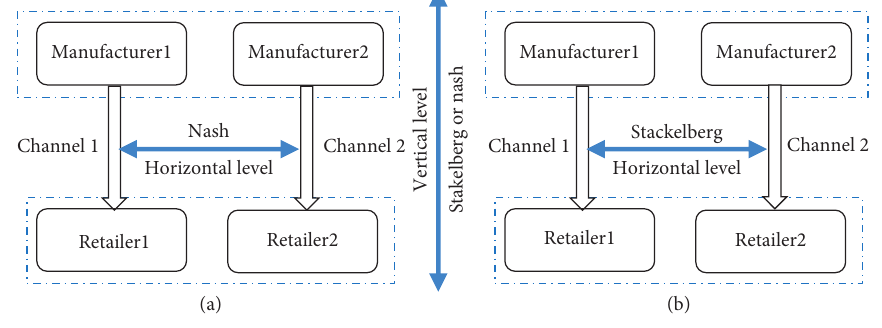
Figure 1: Structures of the dual